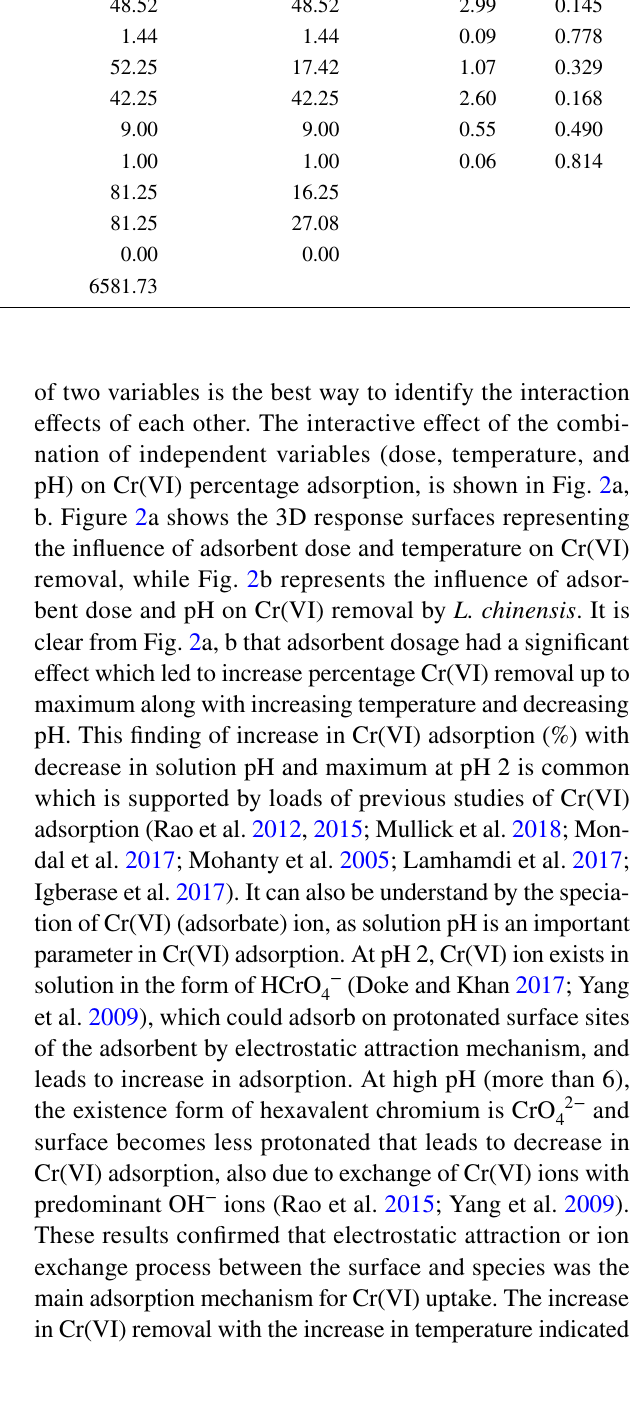
Table 3 Analysis of variance in the regression model for the optimization of Cr(VI) ions